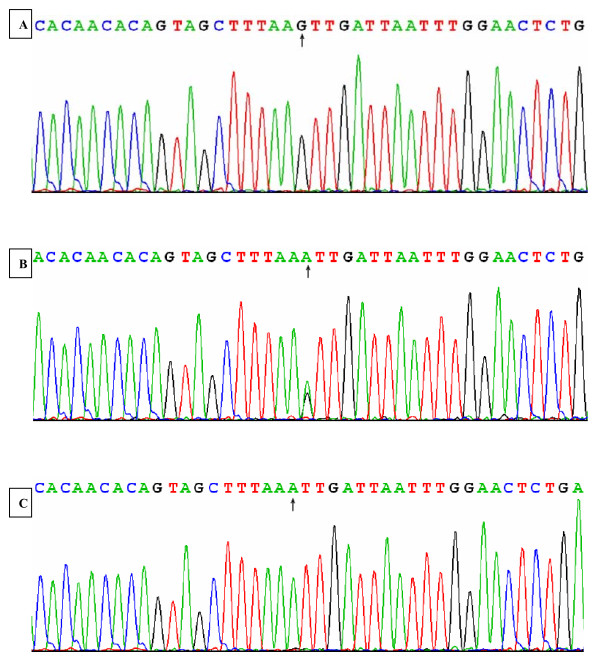
A part of the nucleotide sequence in the LIPC --250G>A locus. (A) GG genotype; (B) GA genotype; (C) AA genotype